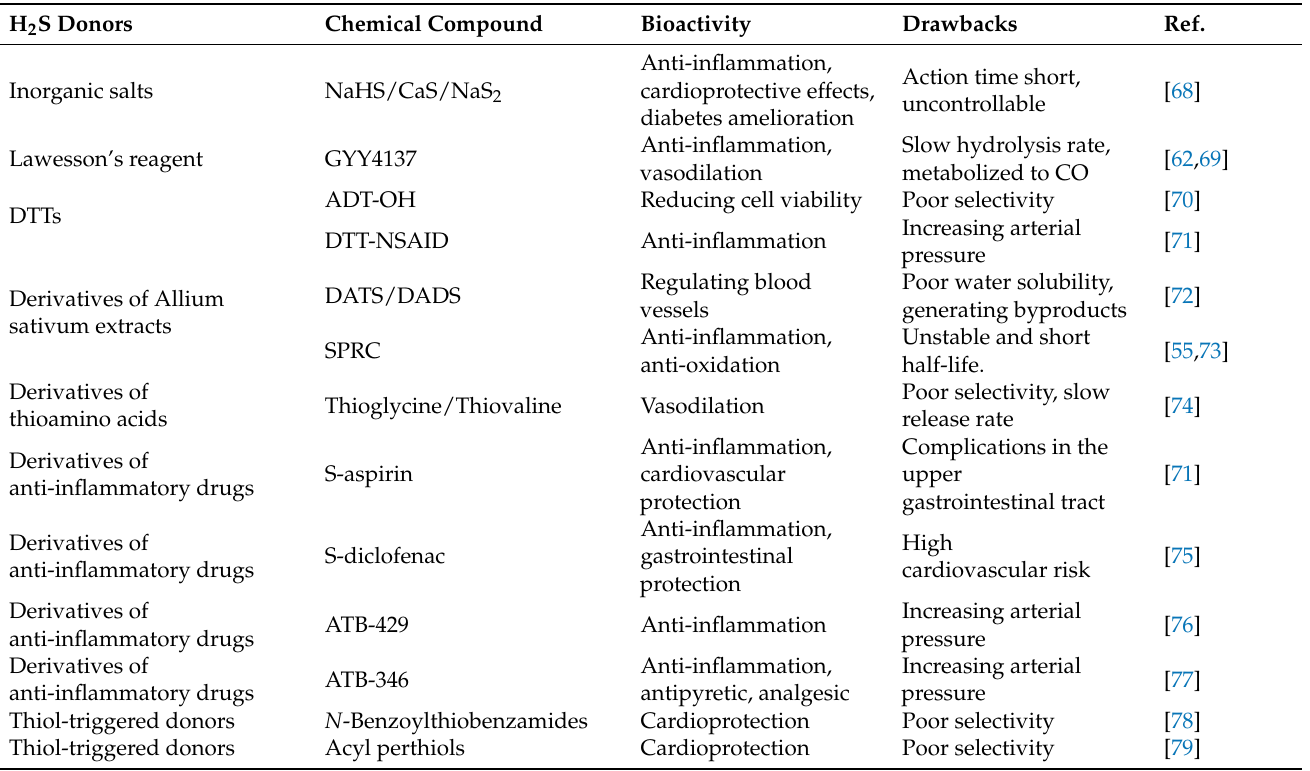
Table 1. Summary of current H 2 S